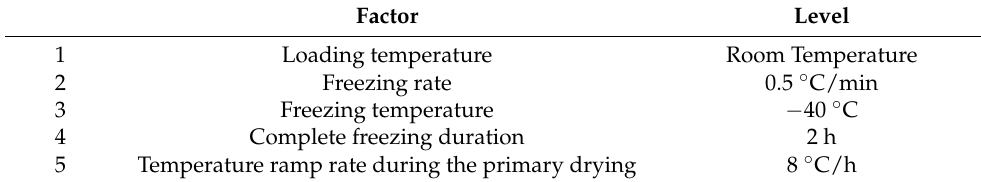
Figure 5. Exterior and interior fruit features at different developmental fruit stages (Hybrid No. 486 from Thailand). Unripe stage: left column ( A , B ); semi-ripe stage: Left column ( C , D ); aril color changing stage: right coumn ( E , F ); ripe stage: right column ( G ), growth habit ( H ).